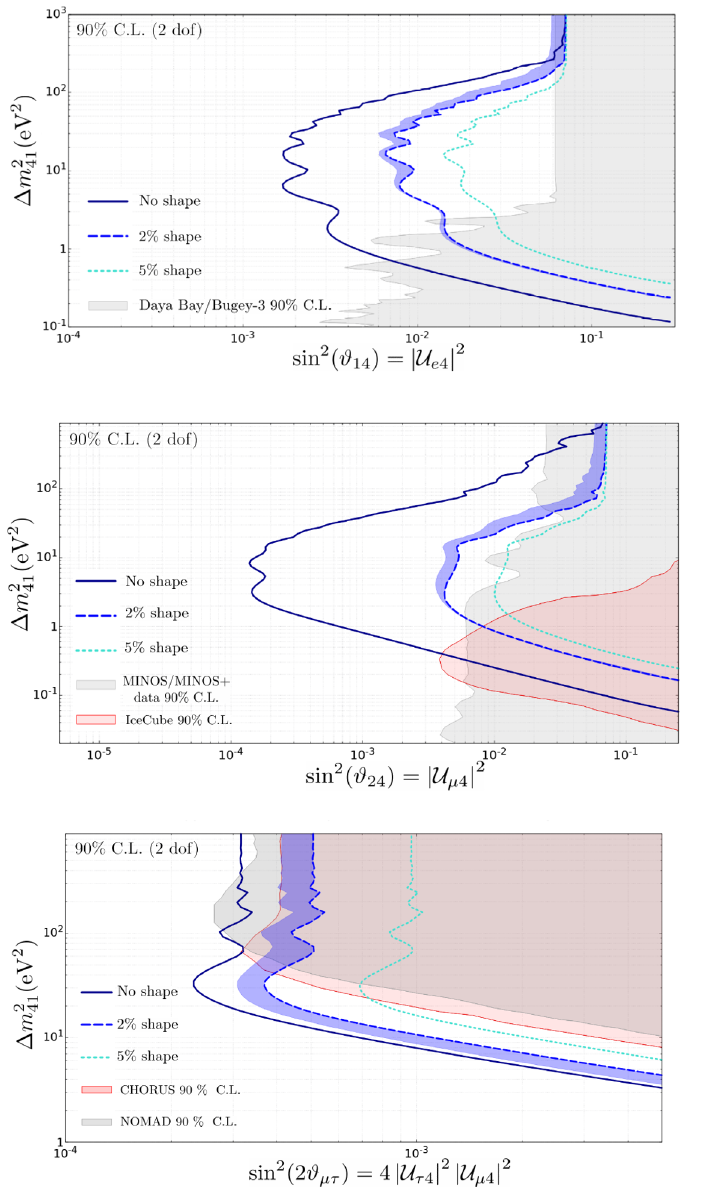
Figure 4 . Expected sensitivity to the sterile neutrino scenario, for oscillations in the P ee , P µµ and P µτ channels for the top, middle and lower panels, respectively. The shaded regions show current constraints from other experiments [65, 99–101], while the colored lines indicate the sensitivity for the DUNE ND, for different choices of systematic uncertainties as indicated by the legend. In each case, the region to the right of the colored lines would be disfavored at 90% CL (2 d.o.f.). Finally, the colored blue bands indicate the increase in sensitivity due to the addition of 3.5 years of data taken in the HE